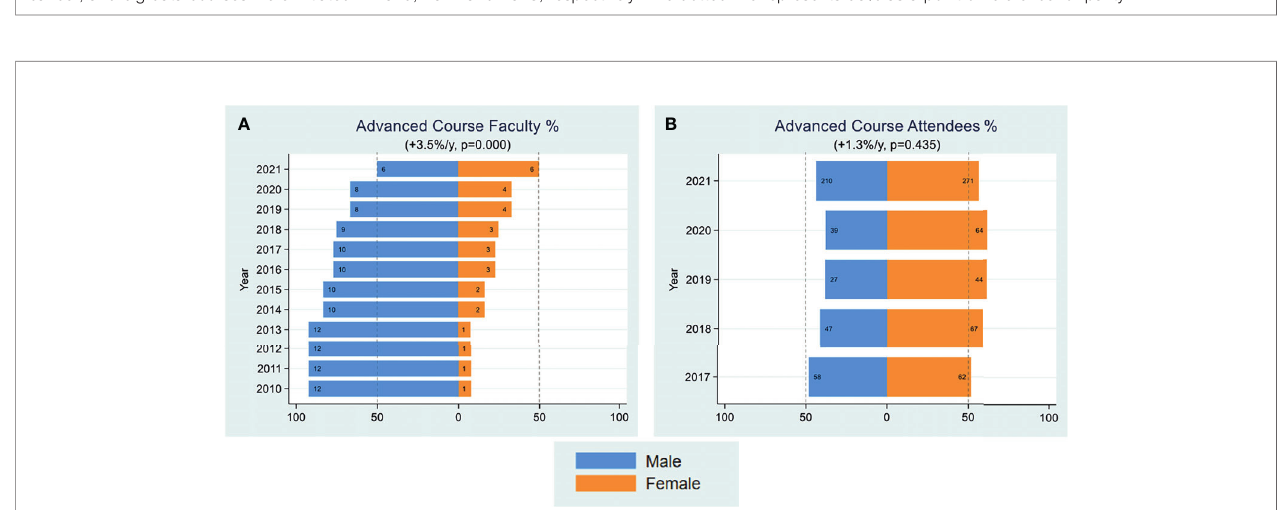
FIGURE 4 | Faculty Workshop. Yearly female percentages of faculty in workshop on subject of basic immunology (A) , cancer (B) , systems/computational (C) , big data (D) and all categories combined (E) are shown over the period 2010-2021. Percentages were based on actual numbers subjects stating their gender. Average changes per year and p-values (shown in parentheses) were estimated by the slope coef fi cient from a simple linear regression model. The systems/computational, cancer, and big data courses were initiated in 2015, 2017 and 2018, respectively. The dotted line represents 50% as a point of reference for